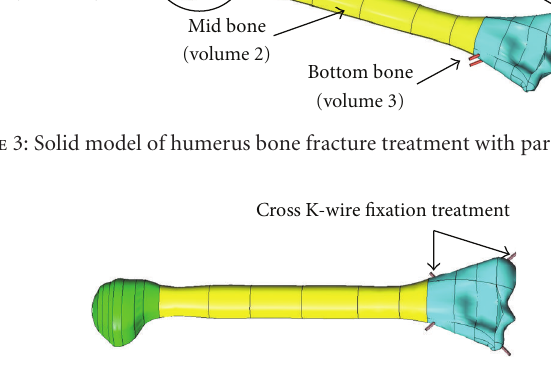
Figure 4: Solid model of humerus bone fracture treatment with crossed